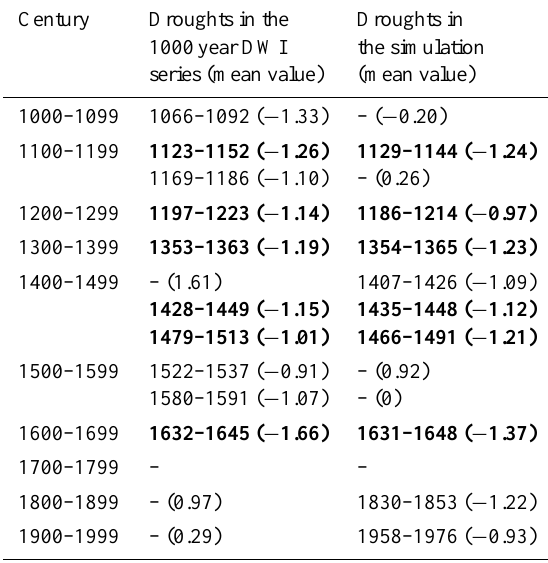
Table 1. Severe decadal droughts over eastern China during the last millennium are identified in proxy and simulated data. Bold-faced years are the droughts captured by both the proxy and simulated